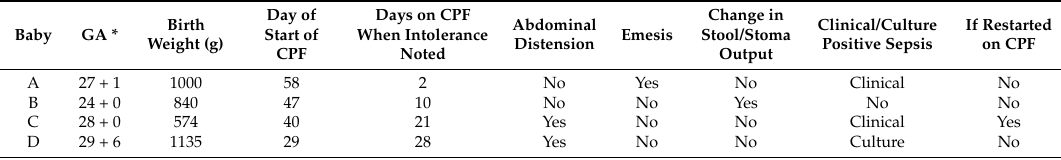
Table 3. Characteristics of babies developing any feed